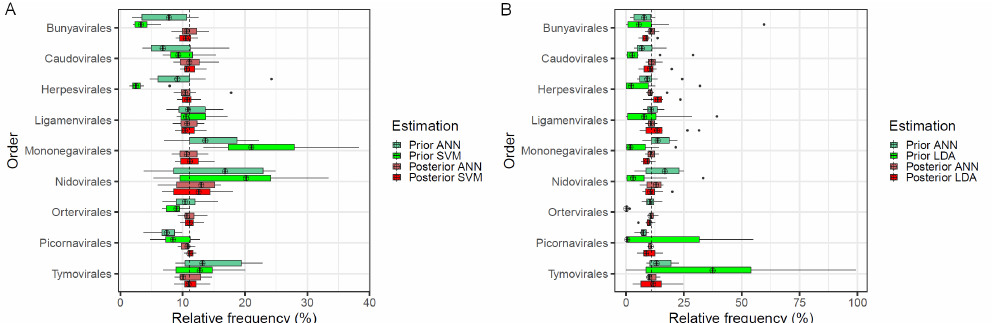
Figure 5. Comparison of estimated taxa frequencies. Distribution of taxa frequencies summarized from 10 simulations runs. Comparison of estimation by an ANN based prior and posterior estimation of taxa frequencies versus SVM ( A ) or versus LDA ( B ) based